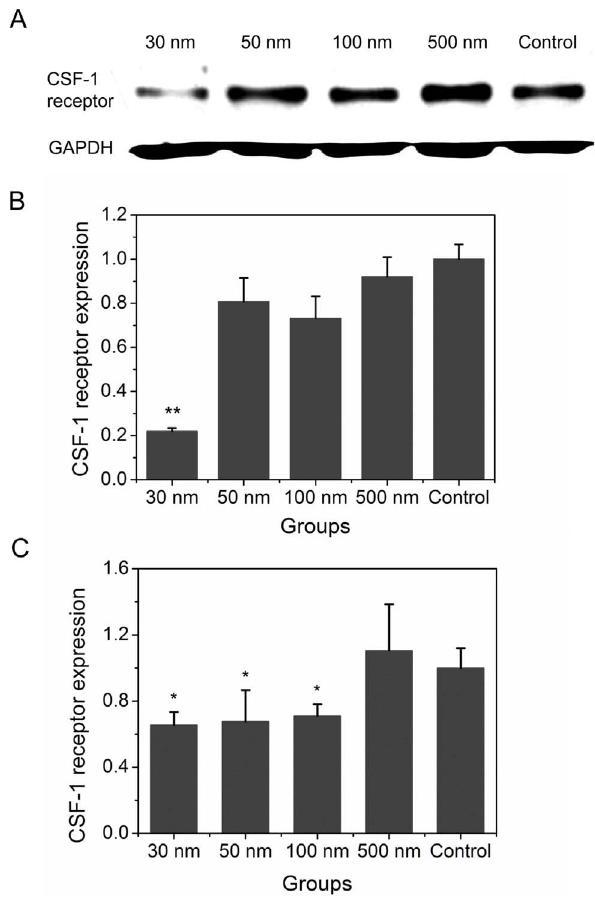
Figure 3. CSF-1 receptor expression after RAW 264.7 uptake of varisized NPs. A) Western blot assay of CSF-1 receptor protein expression. GAPDH served as loading control. B) Histogram showing the results of real-time fluorescent quantitative PCR (Q-PCR) assay of CSF-1 receptor gene expression. * p , 0.05 and ** p , 0.01 compared with control (Error bar is SEM).